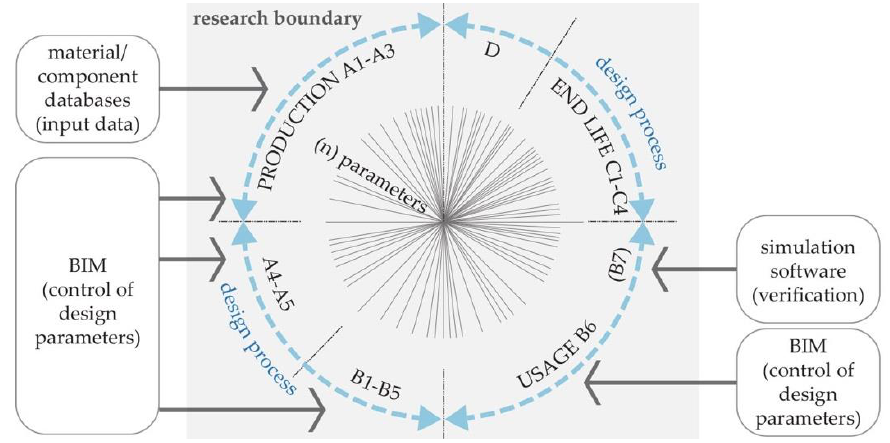
Figure 4. Graphical overview of the use of the mapping, and the boundaries of this research (in grey).